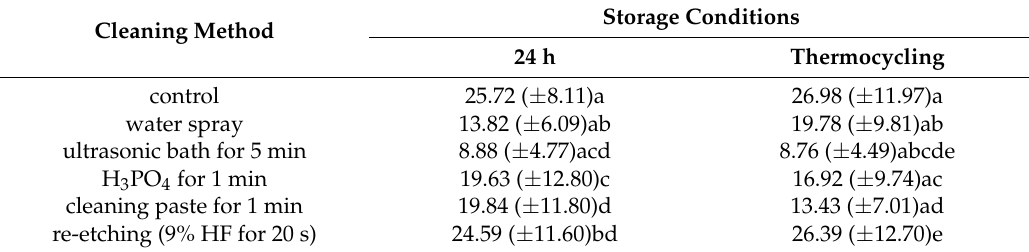
Table 2. Mean shear bond strength values (MPa) ± standard deviation for lithium disilicate glass ceramics (IPS e.max) after different cleaning methods. Within cleaning methods, means followed by different letters (uppercase letters in line and lowercase letters in column) indicate significant statistical